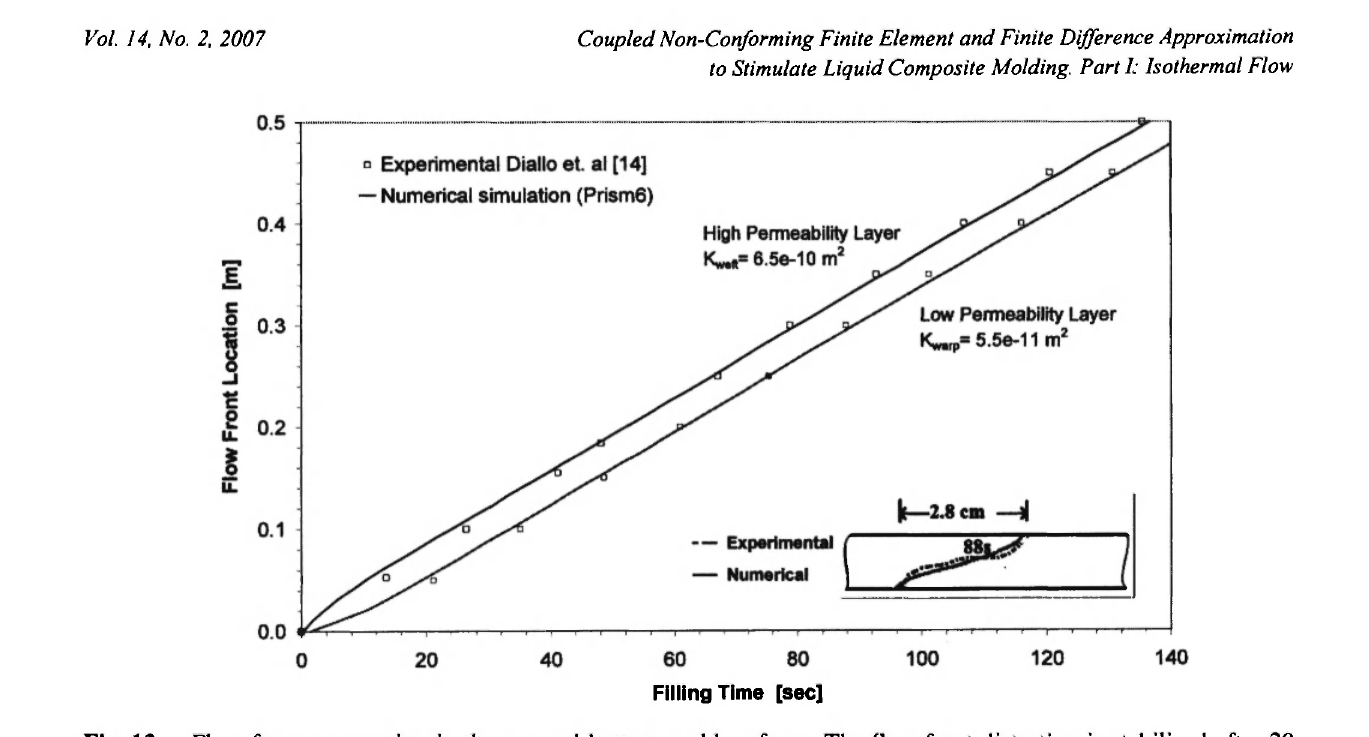
Fig. 12: Flow front progression in the top and bottom mold surfaces. The flow front distortion is stabilized after 20 sec. The numerical through-thickness front at 88 seconds is shown in the bottom right caption and is very close to the experimental profile.